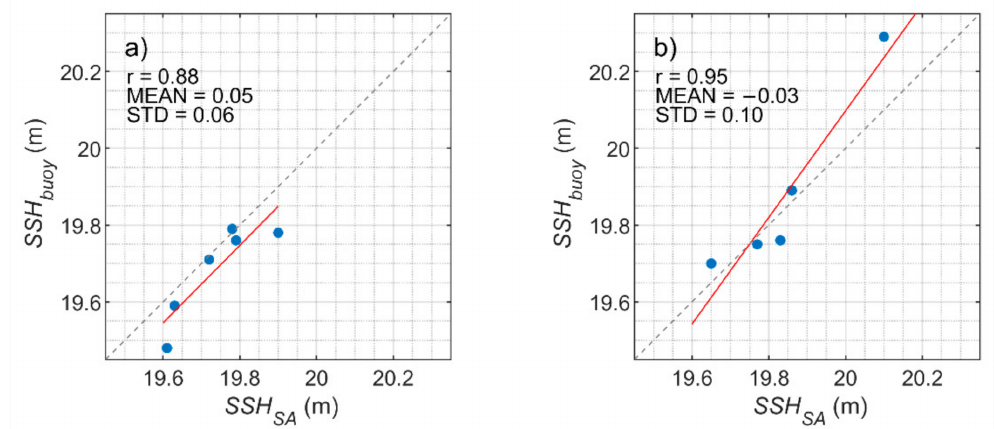
Figure 10. Comparison of Sentinel-3 ( SSH SA ) and buoy ( SSH buoy ) sea surface heights on ( a ) S3A pass 186 and ( b ) S3A pass 397 in the Gulf of Riga. The red line is the linear regression between the two